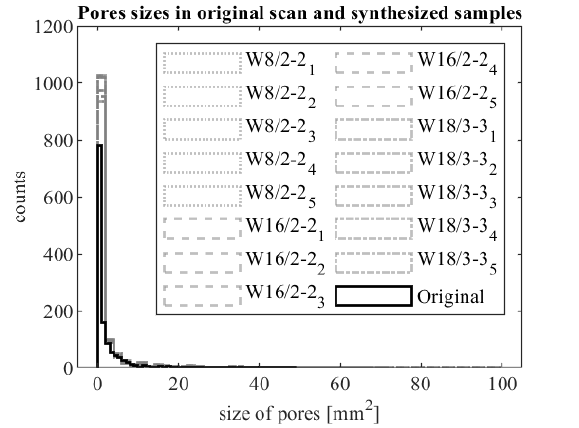
Figure 12. Histogram showing the counts of different size of pores in the original scan and in the synthesized samples for three different sets W8/2-2, W16/2-2 and W18/3-3.